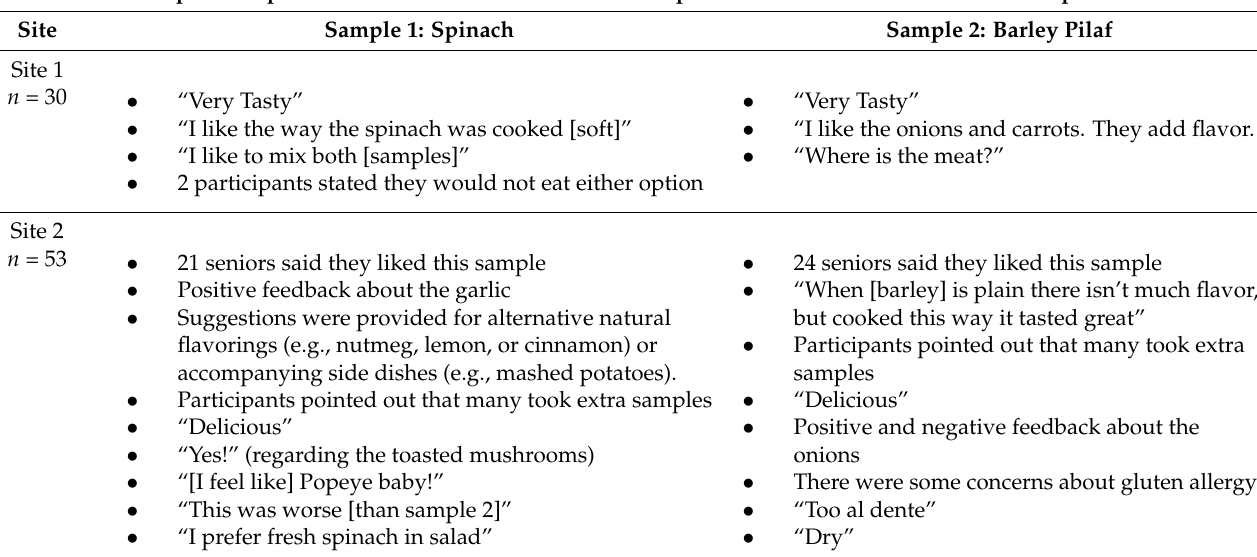
Table 4. Client food preferences at Research Town